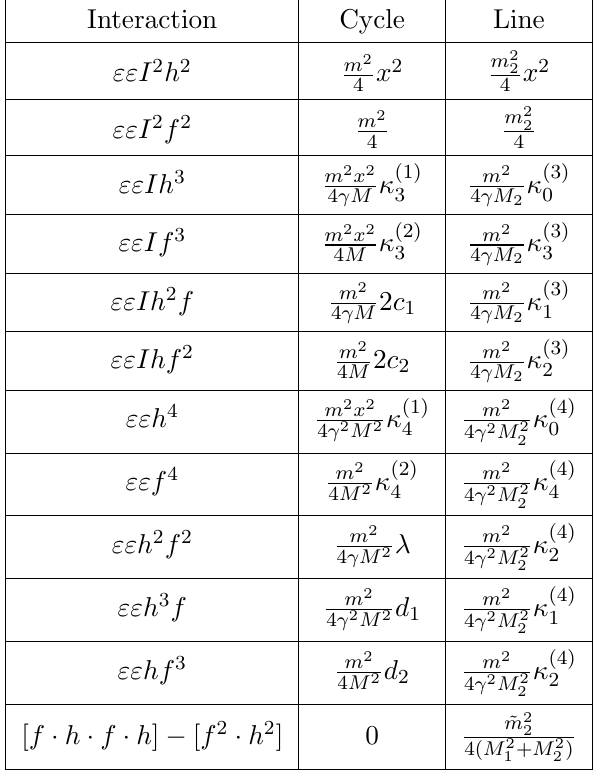
Table 1 . Comparison between the coupling constants appearing in front of the mass and interaction terms in the action for cycle and line interactions, (2.16) and (2.32)